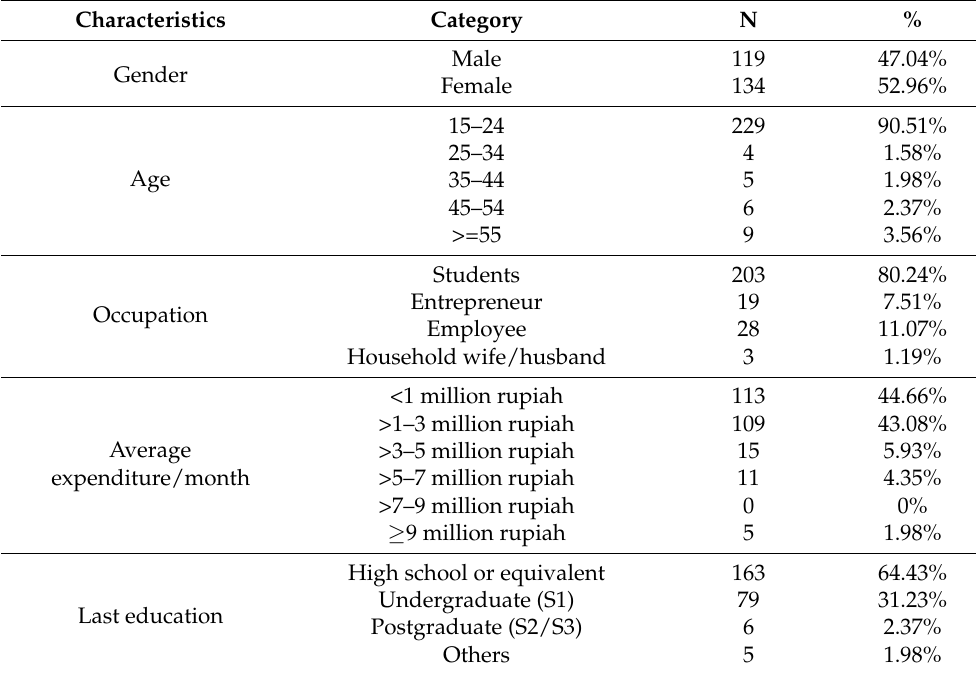
Table 1. Descriptive statistics of